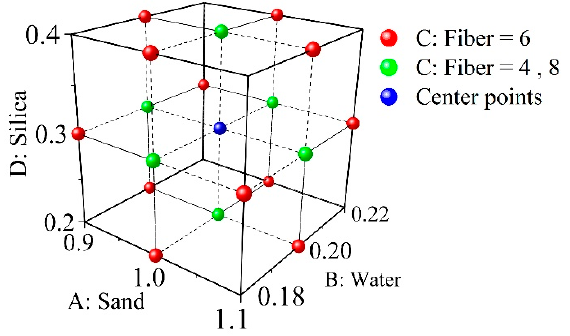
Figure 1. The model concept diagram of the Box-Behnken design (BBD).